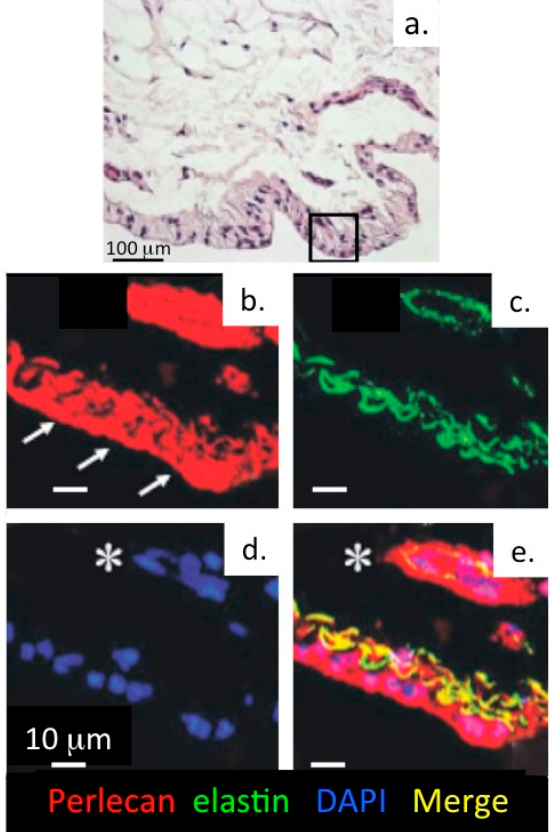
Figure 8. Perlecan and elastin are components of a basal lamina in the knee joint endothelium. ( a ) Haematoxylin & eosin stained tissue section of an 18 month old ovine knee synovium specimen. Confocal localisation of perlecan ( b , red), elastin ( c , green), DAPI-stained cell nuclei ( d ) and merged image showing colocalisation of perlecan and elastin ( e , yellow) within an elastic lamina and surrounding a synovial blood vessel. The arrows indicate the surface of the synovium.The asterisk indicates a blood vessel in the synovium. Figure reproduced from [54] with permission.